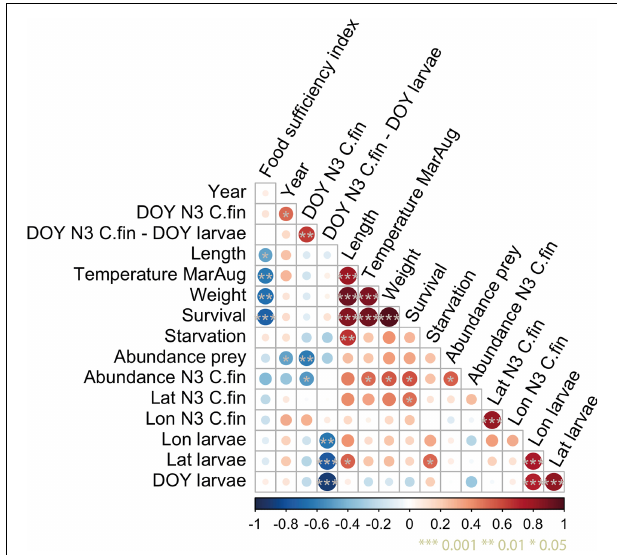
FIGURE 8 | Correlation matrix between variables that indicate survival and match-mismatch between the cod larvae 15 days post-hatch within the polygon and their prey of correct size, Calanus finmarchicus (C. fin) nauplii stage III (N3) abundance, larval length and weight at the end of simulation (30th of September) and survival from the egg stage to age 1 (accounting for size-dependent survival through the first winter). Temperature included in this analysis is the mean temperature from March until August within the main distribution area of cod larvae (the polygon in Figure 1 ) and it is based on the ocean model. DOY corresponds to the day of the year where highest abundance was